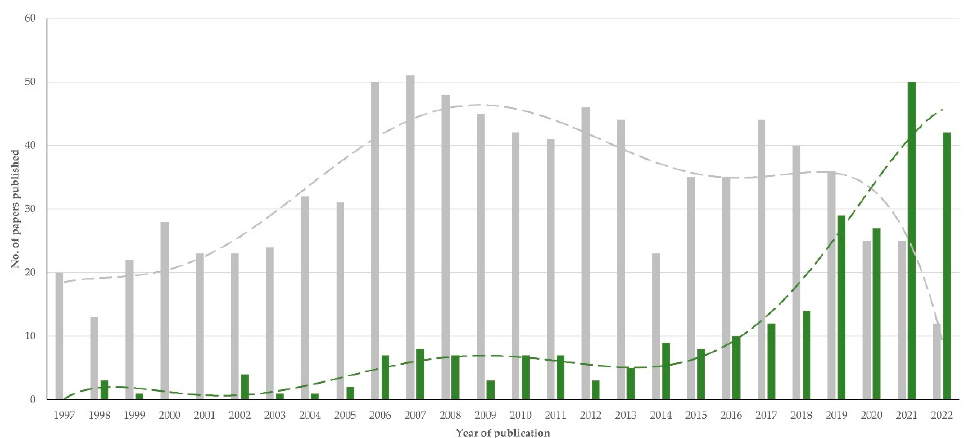
Figure 7. Number of papers on sheep and goats published annually during 1997–2022 in Greece with open (green) or subscription-only (grey) access (dashed lines indicate respective trendlines).